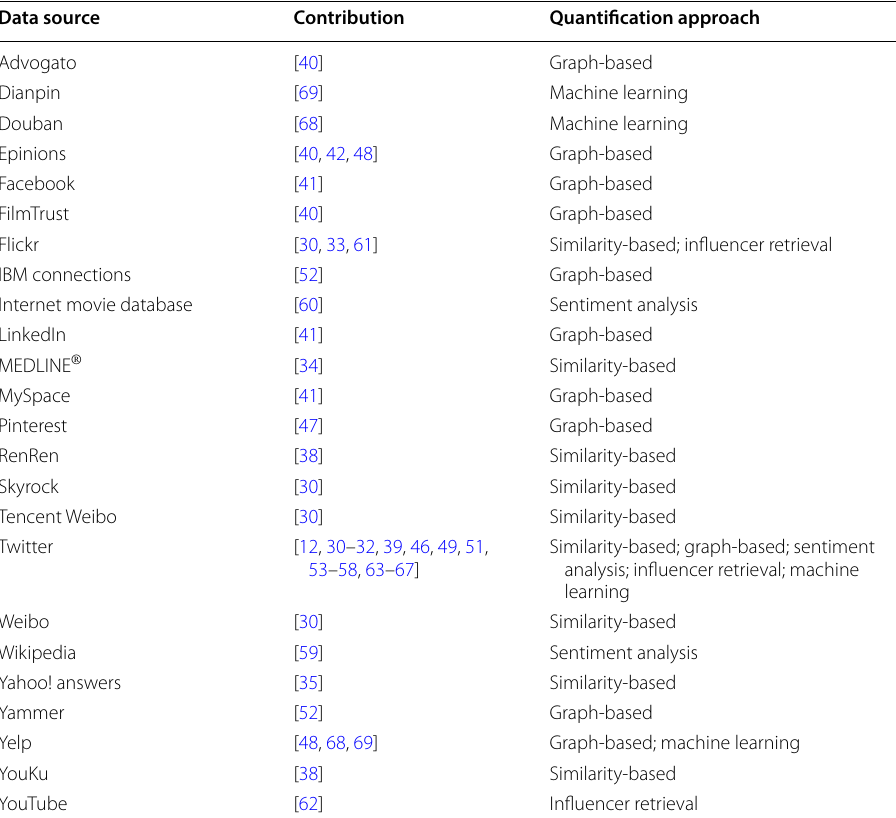
Table 1 Major quantification approaches for measuring domain-based trust related to different online social